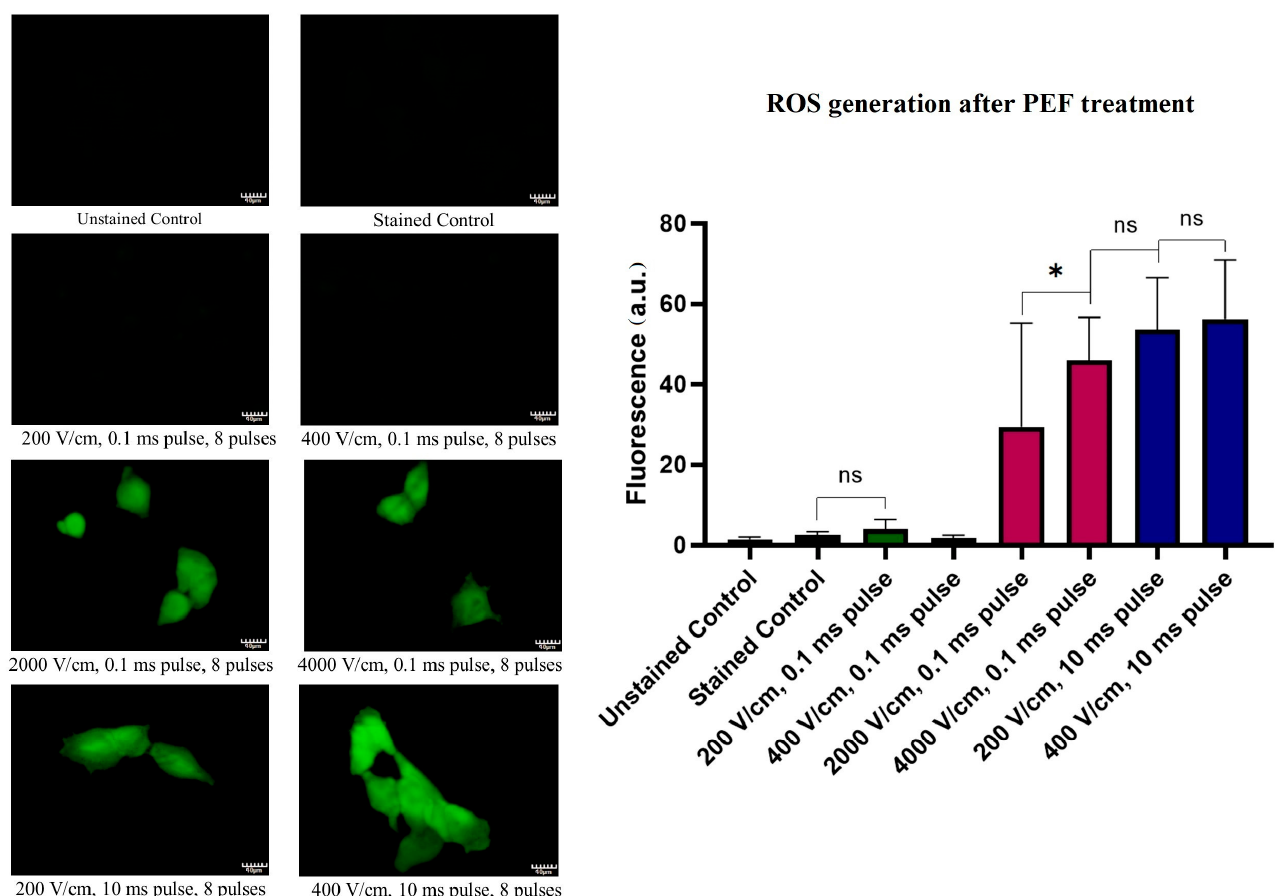
Figure 6. Oxidation stress induction 12 h after PEF treatment. The left side panel reports representative fluorescent photographs (40 × ) of the cells stained with CM-H 2 DCFDA. The right panel reports the statistical analysis of the samples. Green bars represent 200–400 V/cm, 0.1 ms pulses; blue bars represent 200–400 V/cm, 10 ms pulses; red bars represent 2–4 kV/cm, 0.1 ms pulses. The fluorescence of the samples presented as the mean ± SD. One-way ANOVA analysis: * p < 0.05, ns p > 0.05. Scale bar—40 μ m.